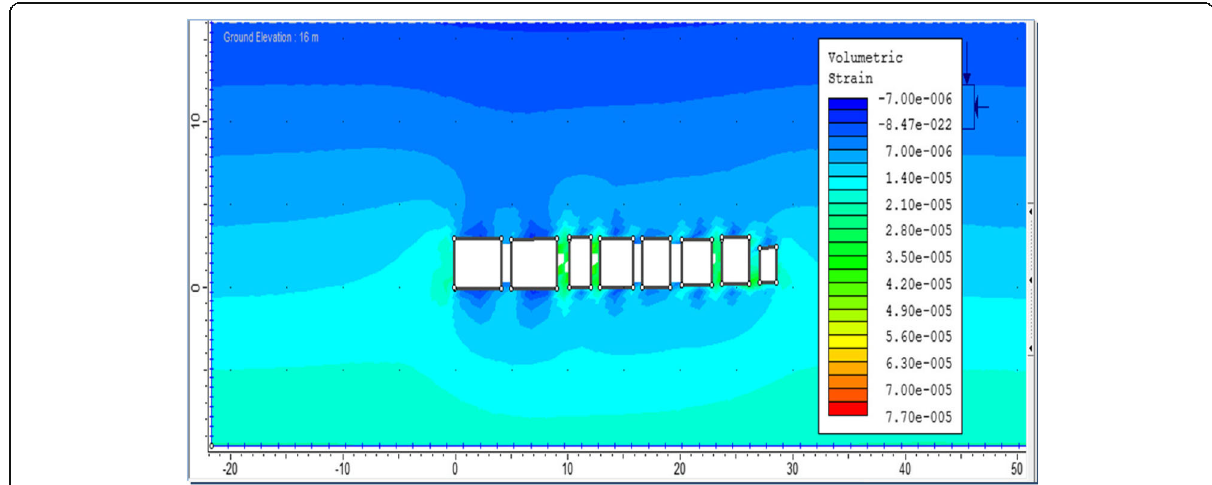
Fig. 16 Volumetric strain distribution through the rock pillars in Chamber 3. Examine